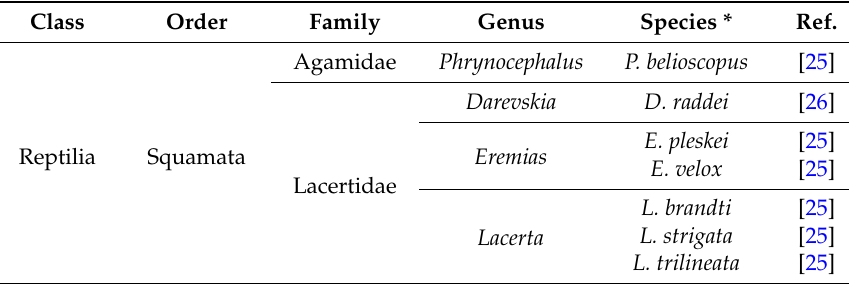
Table 8. List of reptiles from the National Park of Urmia